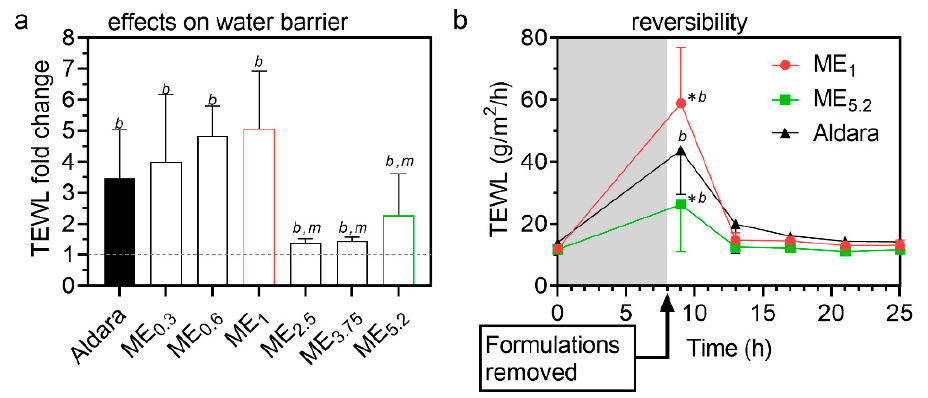
Figure 5. Interaction of selected MEs with the skin barrier. ( a ) TEWL fold change after/before treatment. Formulations were applied for 8 h and then carefully removed. TEWL values were obtained 1 h later to prevent interference with formulation residues. Data are presented as the means ± SD, n ≥ 4. b significant against baseline value (before treatment), m significant against ME 1 at p < 0.05. ( b ) Rapid reversibility of TEWL values after cessation of treatment with selected formulations. Means ± SD, n ≥ 4. * Significant against Aldara at the same time point; b significant against baseline value (before treatment) at p < 0.05.